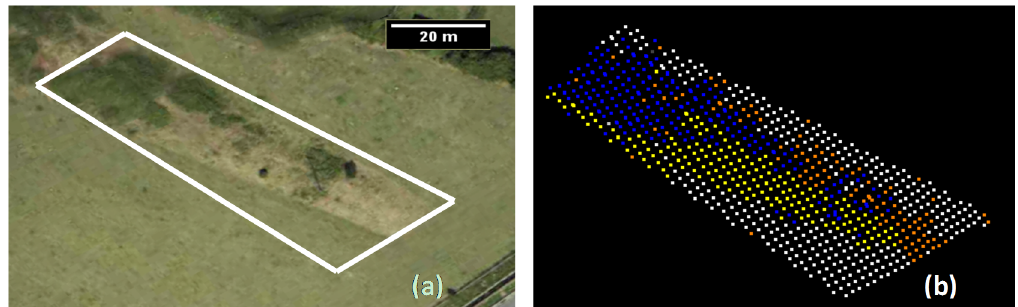
Figure 6. Segmentation of natural terrain target: ( a ) orthophoto ( b ) segmented point